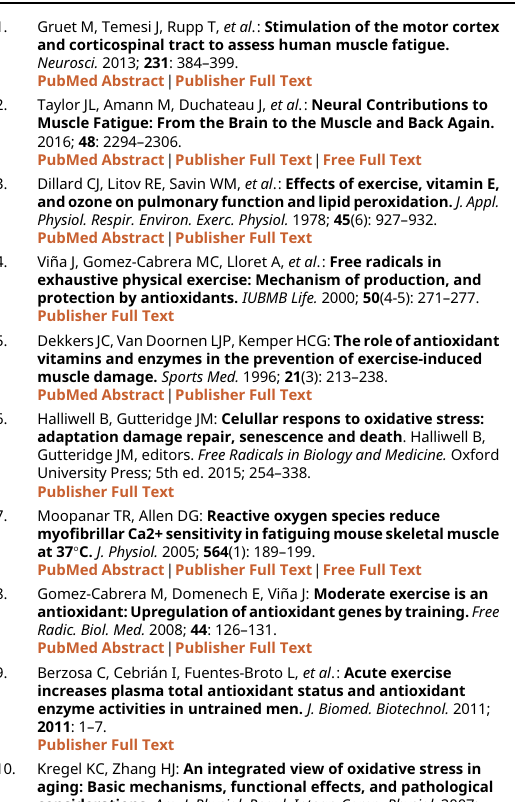
Figshare: Datasets, https://doi.org/10.6084/m9.figshare.15074544.v5. 51 This project contains the following underlying data: - MDA RAT.xls (MDA levels for all groups) - SOD RAT 23 Maret 21.xls (SOD levels for all groups) - Table HEnew.docx (scoring for microscopy results)